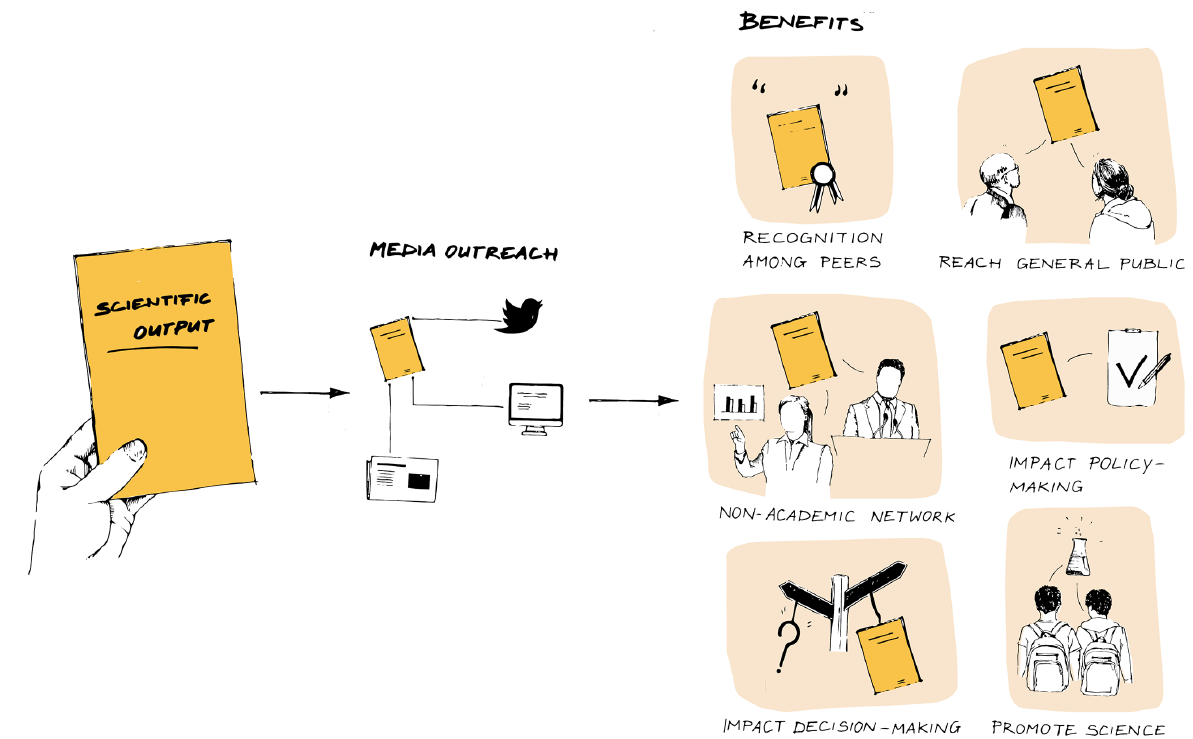
Figure 1. The benefits of communicating your research via the media (figure by Cher van den